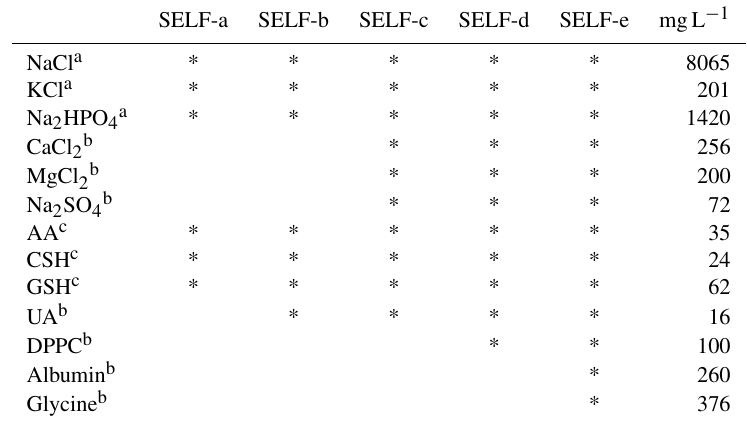
Table 1. Compositions of SELF used in this study.